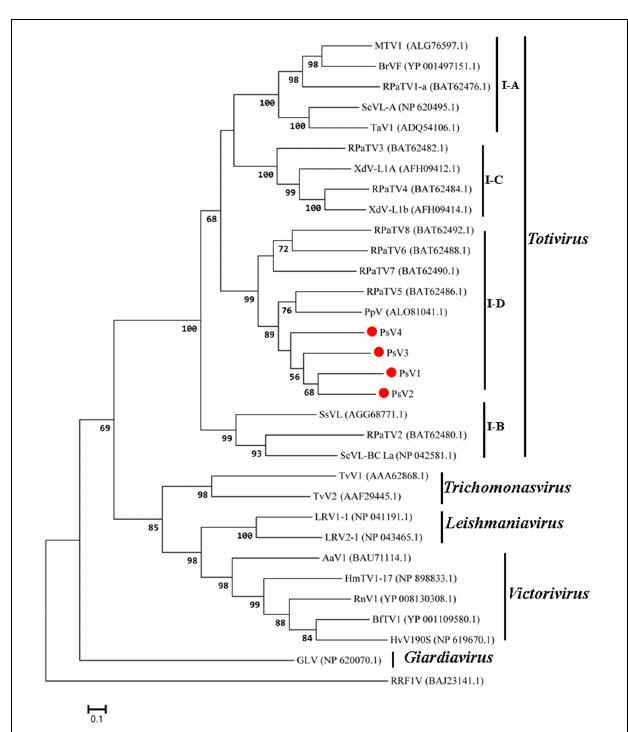
FIGURE 5 | Phylogenetic analysis based on the deduced amino acid sequences of putative RdRps using the maximum likelihood (ML) method with 1,000 bootstrap replicates. The scale bar represents a genetic distance of 0.1 amino acid substitutions per site. Red circles indicate the novel mycoviruses PsVs in the present